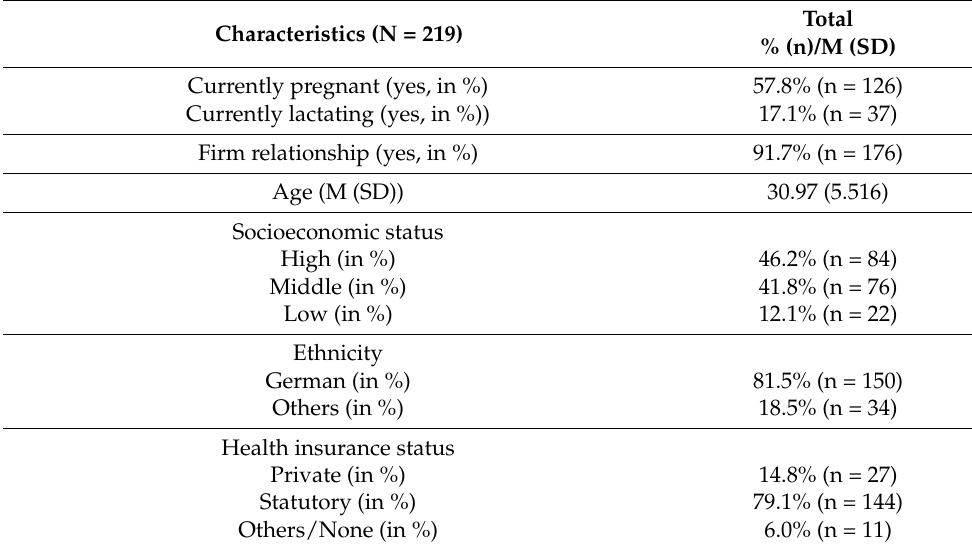
Table 1. Sample characteristics with frequencies (%) and means (SD).